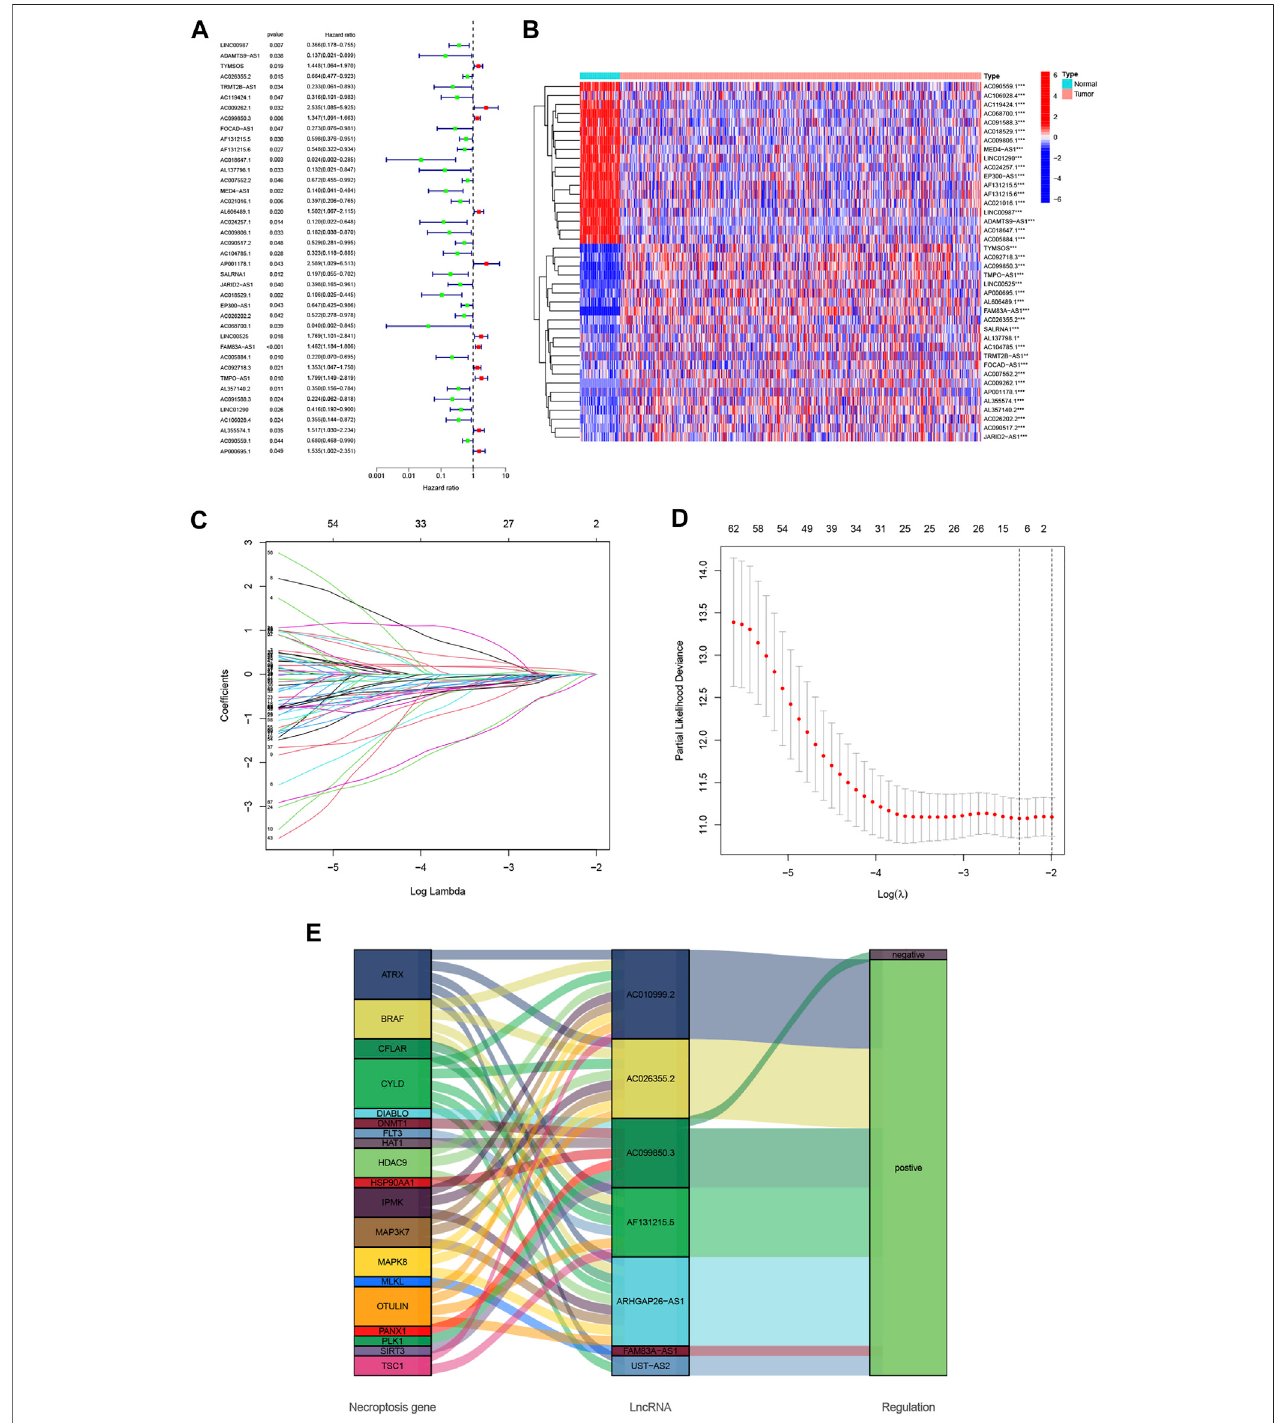
FIGURE 1 | Identi fi cation of necroptosis-related lncRNA prognostic signature in lung adenocarcinoma (LUAD). (A) Forest plot of 40 necroptosis-related lncRNAs selectedbyunivariateCoxregressionanalysis. (B) Thedifferentialexpressionsof40necroptosis-relatedlncRNAslinked tosurvivalbetweenLUADand normalsamples. (C) The 10-fold cross-validation for variable selection in the least absolute shrinkage and selection operator (LASSO) algorithm. (D) The LASSO coef fi cient pro fi le of necroptosis-relatedlncRNAs. (E) TheSankeydiagramoftheconnectionbetween19necroptosis genesand7necroptosis-relatedlncRNAs.* p < 0.05,** p < 0.01, *** p < 0.001.